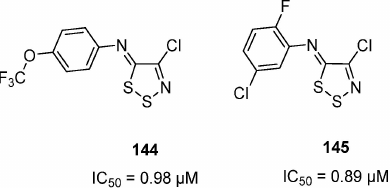
Figure 33. Anticancer 1,2,3-dithiazoles targeting transporter protein LAT1